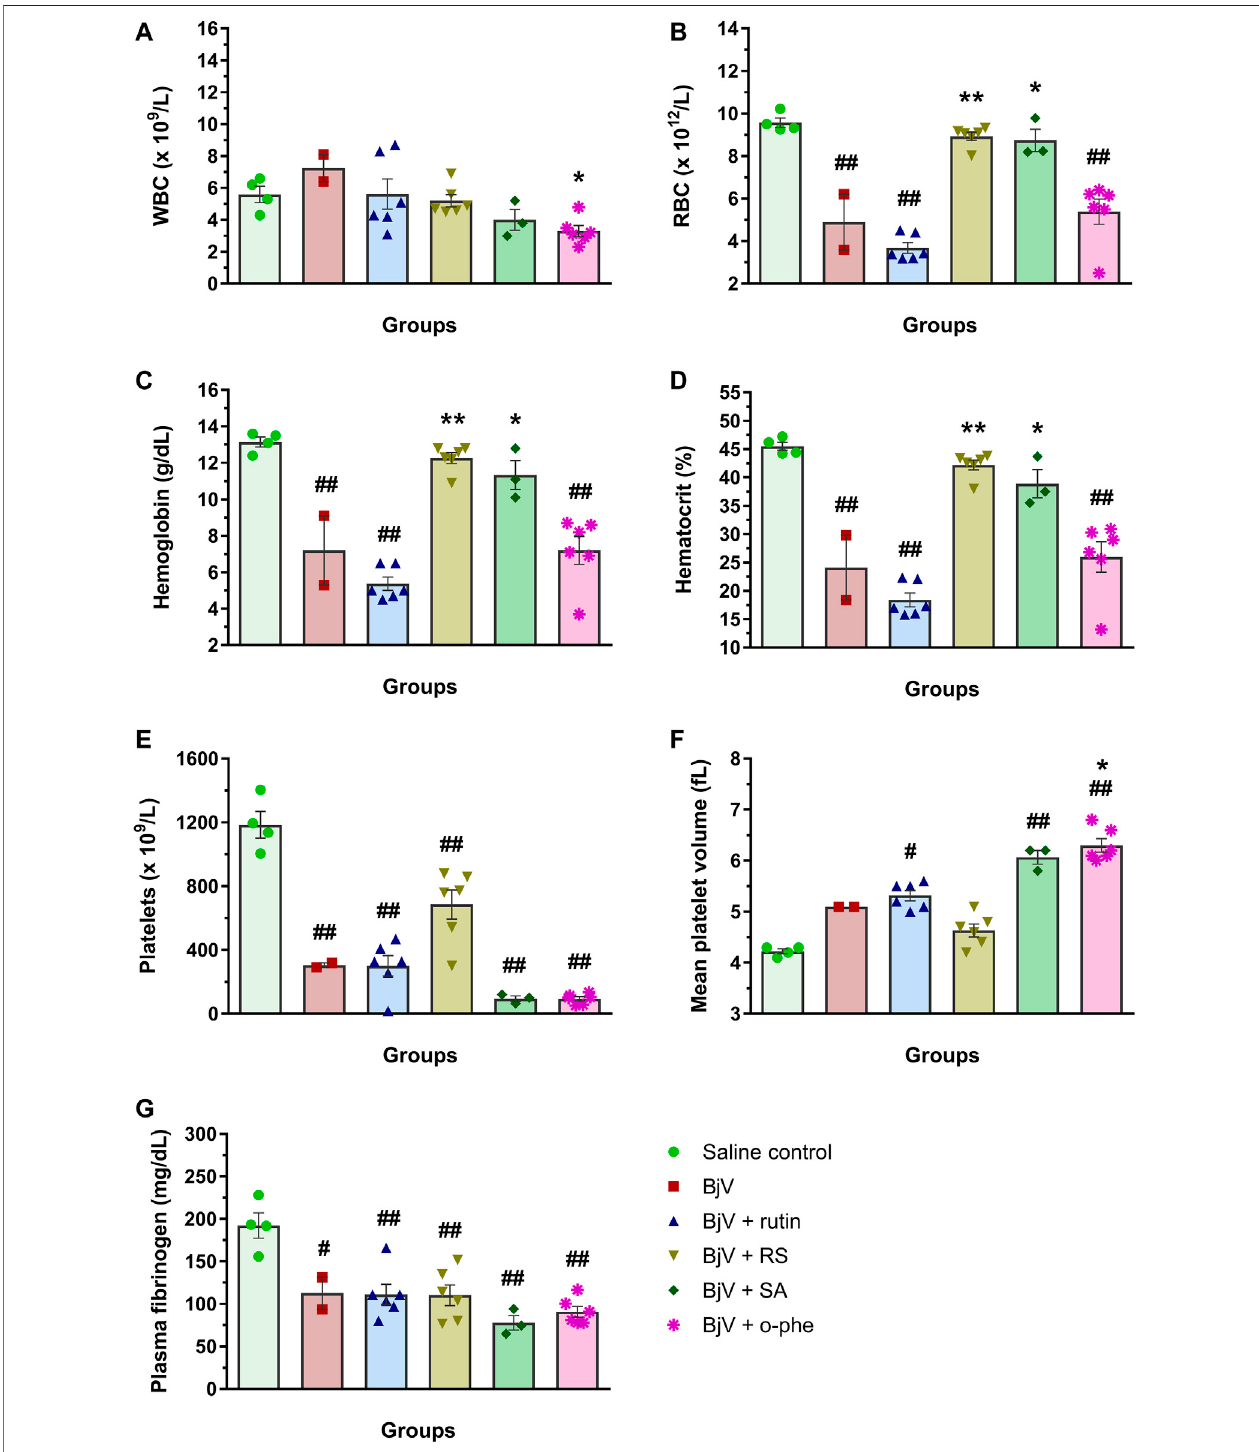
FIGURE 14 | (A) WBC counts, (B) RBC counts, (C) hemoglobin, (D) hematocrit, (E) platelet counts, (F) MPV and (G) plasma fi brinogen of mice 48 h after the injection of saline, BjV, BjV + rutin, BjV + RS, BjV + SA and BjV + o-phe (BjV dose: 3LD 50 ). One-way ANOVA was used, followed by Bonferroni post-hoc test; # p < 0.05 and## p < 0.001whencomparedtosalinecontrolgroup;* p < 0.05and** p < 0.001whencomparedtoBjVgroup.Dataareexpressed asmean±SEM.( n =3 – 6/group).